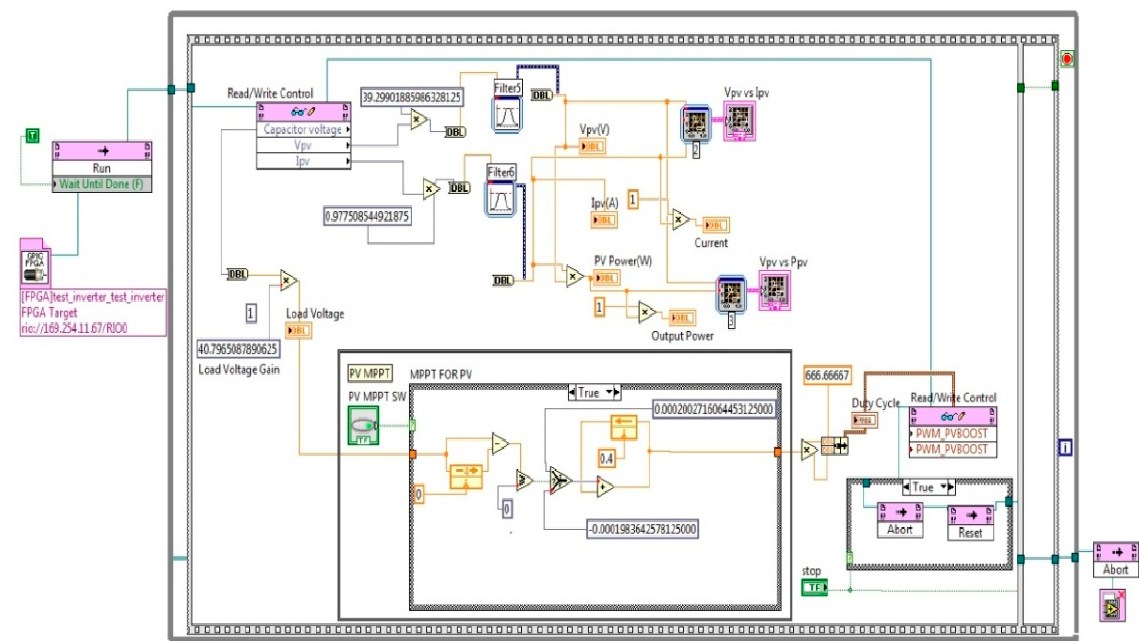
Figure 17. Labview block diagram of proposed MPPT technique.